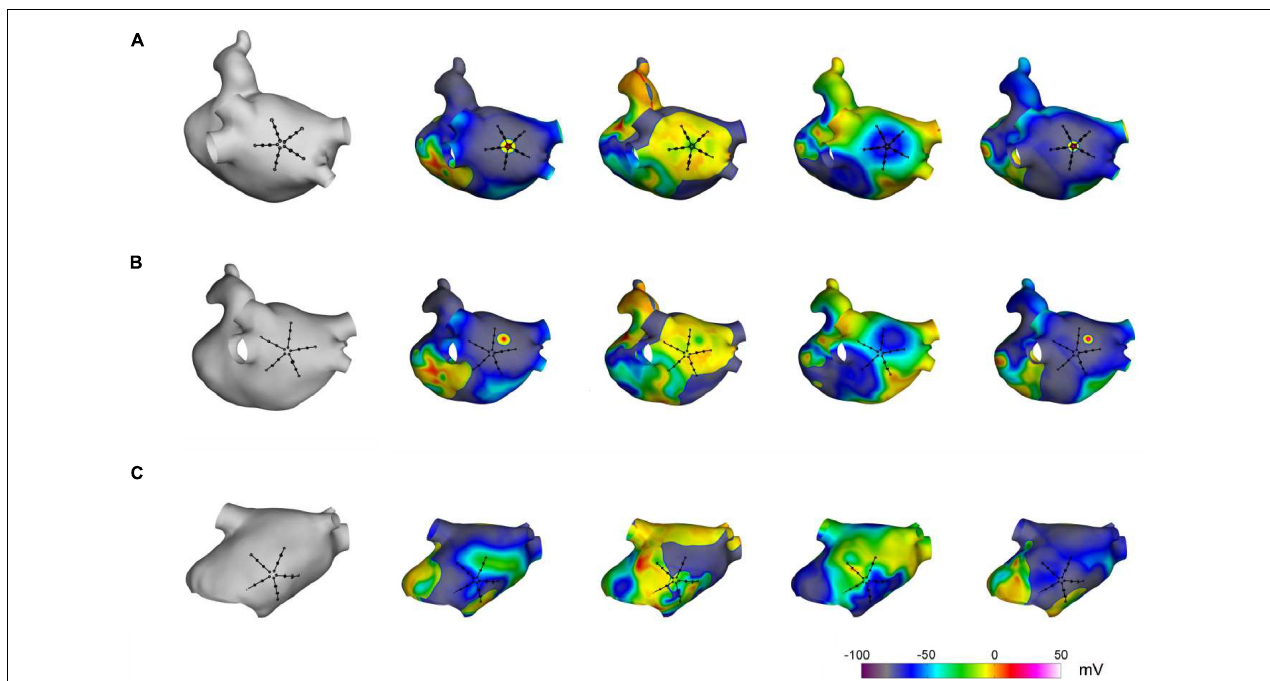
FIGURE 2 | Simulation of atrial fibrillation in a realistic left atrial model. In gray, anatomical model of the left atrium and positions of the simulated multipolar catheter. In color, sequential snapshots of the membrane voltage at three mapping sites: at the focal driver (A) , at the boundary between the focal driver and multiple wavelets region (B) , and in the multiple-wavelets region (C)